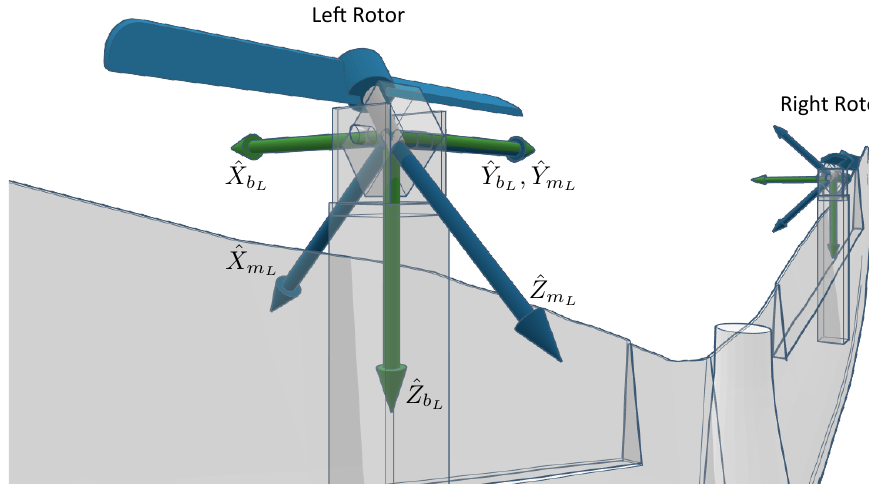
Figure 5. Left rotor coordinate reference